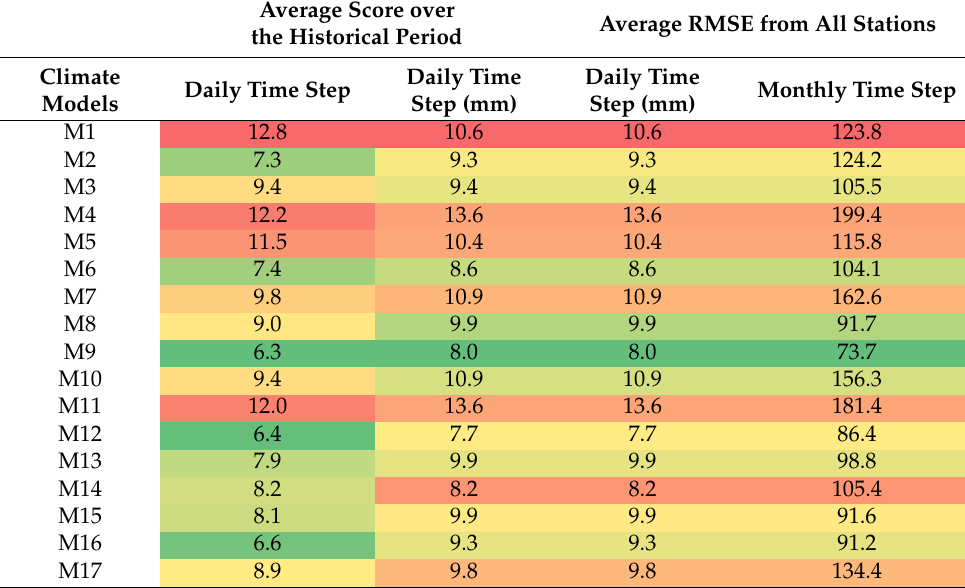
Table 2. Average overall score and RMSE value of individual climate models from all rainfall stations in daily and monthly time steps over the historical period (1986–2005). Average Score over the Historical